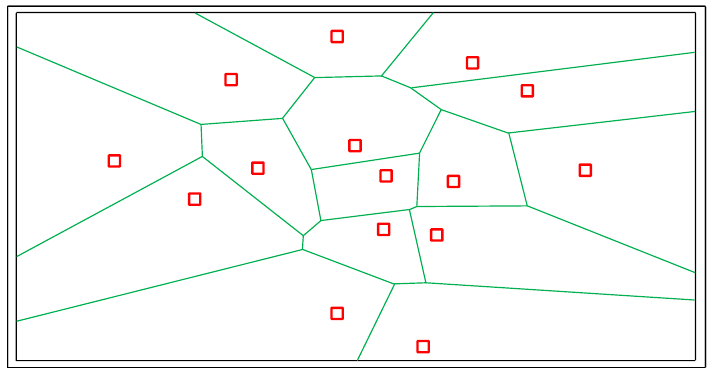
Figure 4. Example of a two-dimension space Voronoi diagram for fifteen sites denoted by red squares.